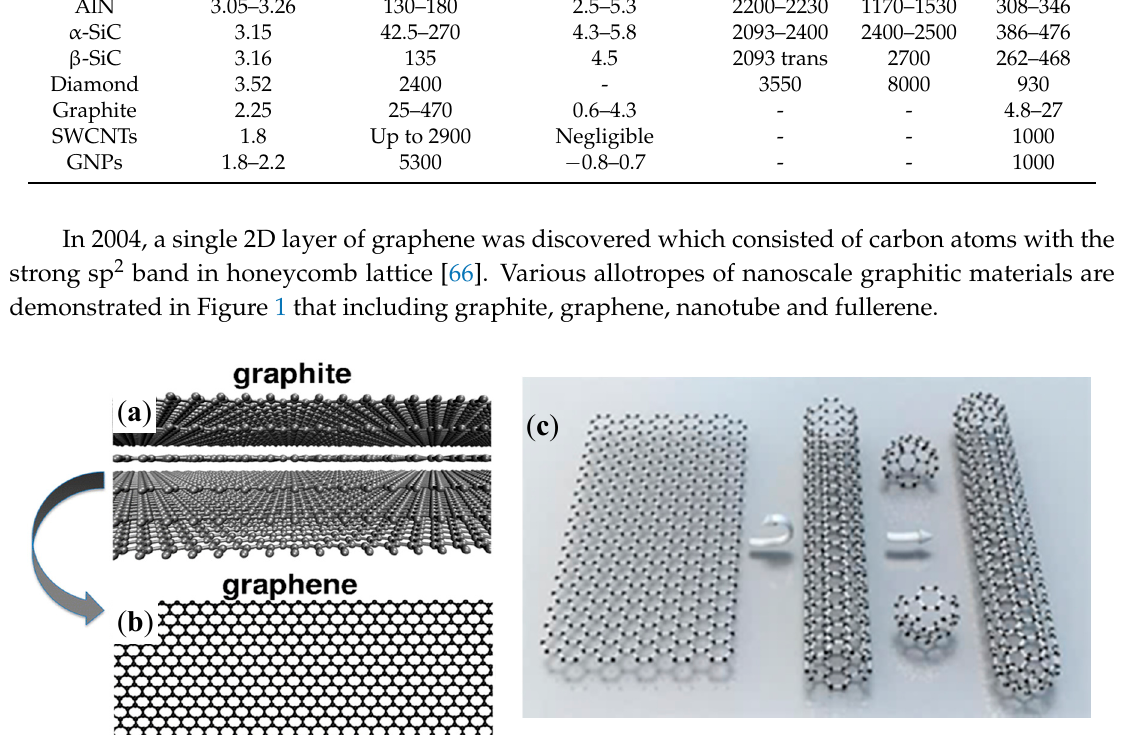
Figure 2. Publication trend in graphene chorology between 2004 and 2018 in ScienceDirect (this graph is plotted based on the simple searching of “graphene” at www.sciencedirect.com). As a matter of fact, graphene nanoplatelets with platelet morphology include some graphene sheets bonded to each other by interatomic Van der Waals force. In general, it is shown that the